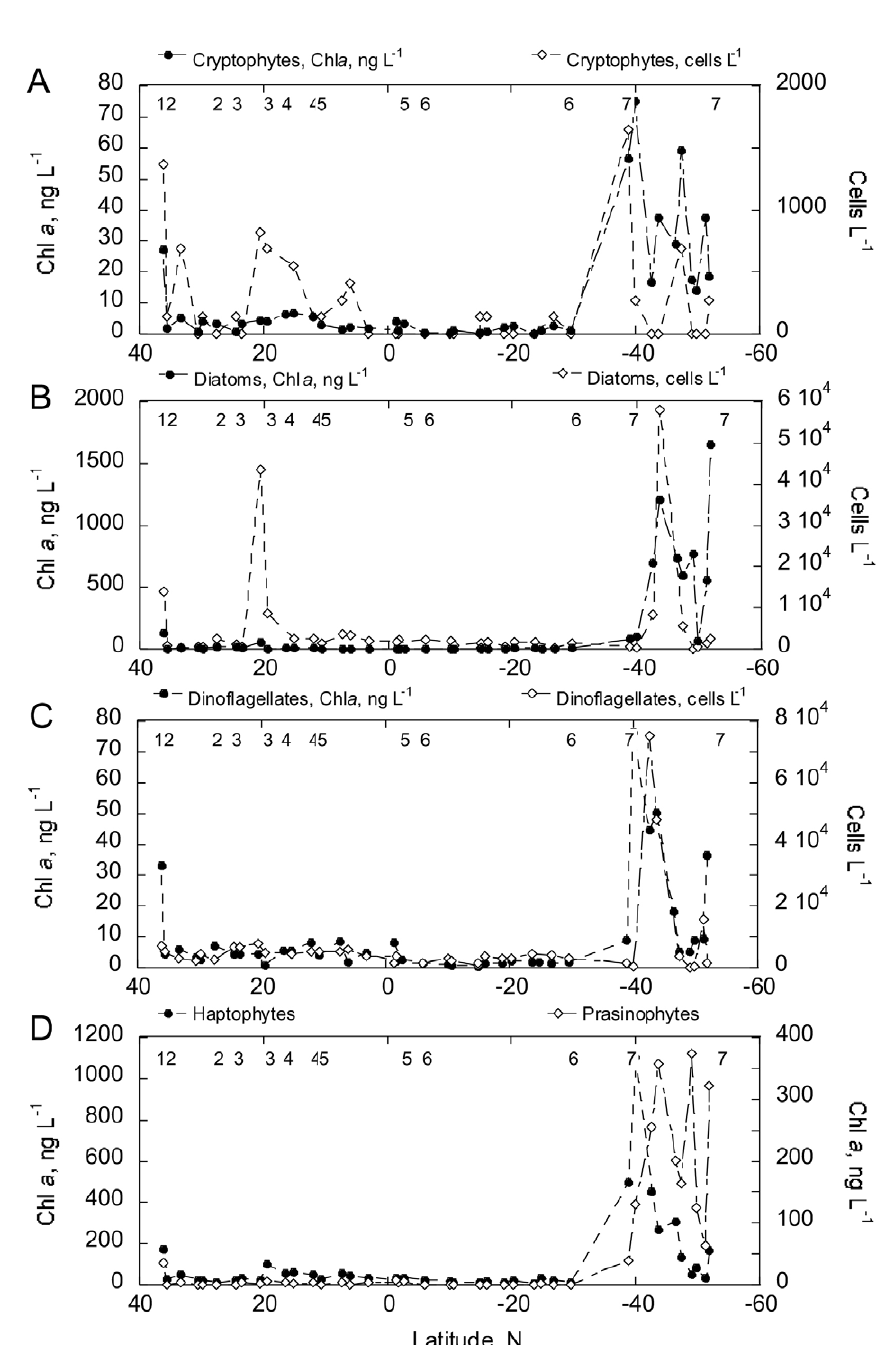
Fig. 6. – Latitudinal variation of CHEMTAX-derived Chl a (ng L –1 ) and cell counts (cells L –1 ) for cryptophytes (A), diatoms (B), dinoflagel- lates (C), and latitudinal variation of CHEMTAX-derived Chl a (ng L –1 ) for haptophytes (left ordinate scale) and prasinophytes (right ordinate scale)